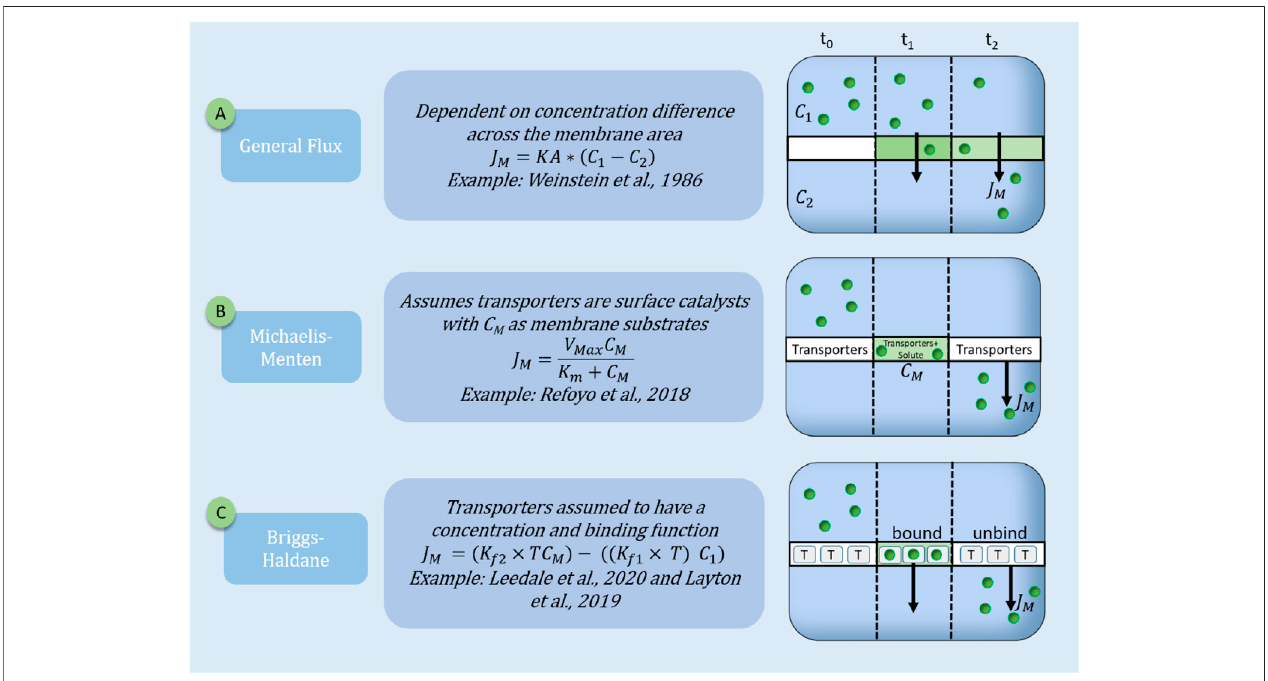
FIGURE 1 | Schematic representation of three transporter models. Transporter models are represented by the fl ux boundary conditions of the transporter membrane over three time-steps (t 0 (cid:2) initial time point; t 1 (cid:2) intermediate and t 2 (cid:2) steady-state). J M is the resulting membrane fl ux (molecules.cm − 2 .s − 1 ). The three standard equations are: (A) General Flux: with KA as the mass transfer area coef fi cient, C 1 and C 2 are the concentrations of the solute in the compartments; (B) Michaelis-Menten:withC M isthesoluteconcentrationinthemembrane,K m andV max aretheMichaelis-Mentenconstants; (C) Briggs-Haldane(massaction):withT is transporter concentration; TC M is the solute bound transporter; K f 1 and K f 2 is the on and off binding rate of the transporters with the solute.